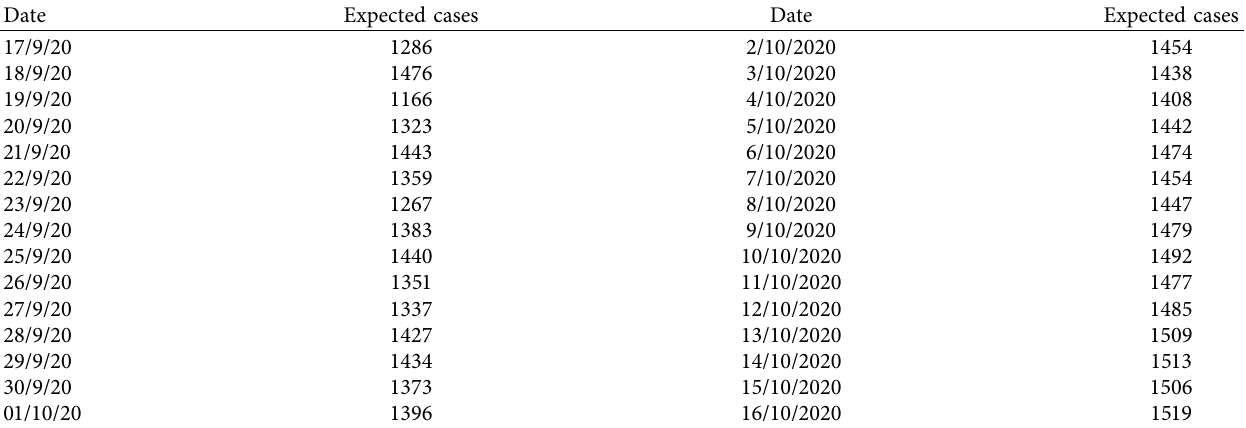
Table 4: The prediction results of daily confirmed COVID-19 cases in East Africa for the next month as predicted by the ARIMA (3, 1, 3)